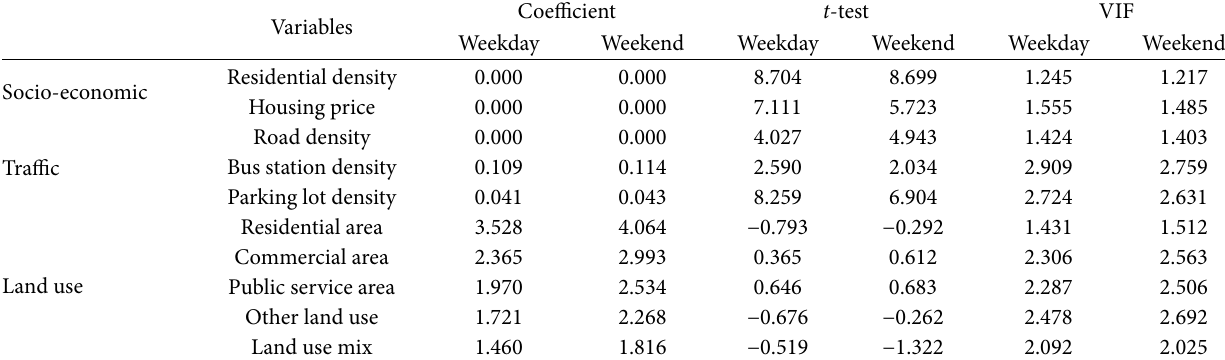
Table 3: Estimation results for global models (OLS).